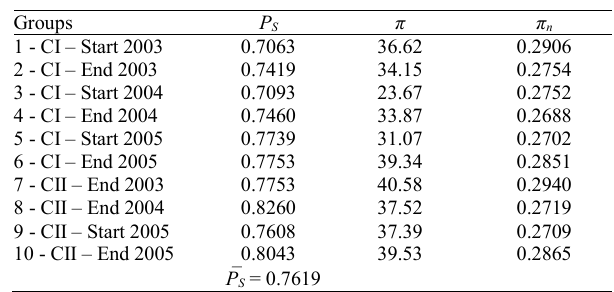
Table 2. Intrapopulational genetic diversity based on RAPD markers for the groups of Leporinus elongatus from the fish passage ladders of HEPs Canoas I and Canoas II - Paranapanema River. P : proportion of polymorphic sites; P : S S mean proportion of polymorphic sites; π mean gene diversity between pairs of haplotypes; π mean gene diversity over all n loci. Start: collected from January to March; End: collected from October to December.